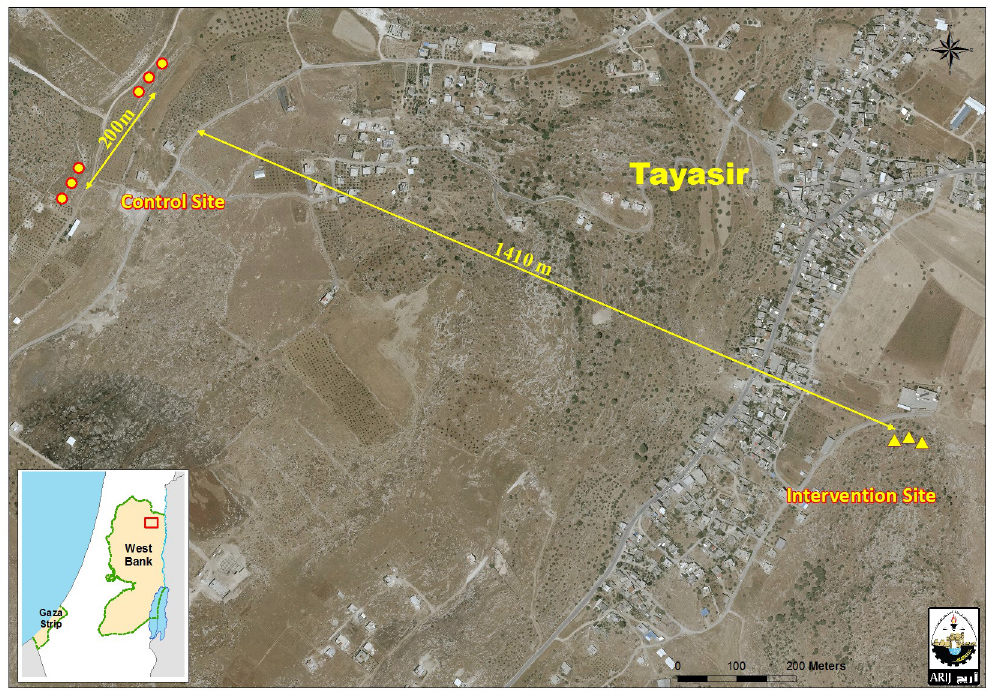
Fig 1. Map of Tayasir village with hyrax den locations used as control (circles) and intervention (triangles) sites. The study population consisted of the sand flies captured in the study sites during the study period. No ethical approval was obtained for this study because it did not involve any human